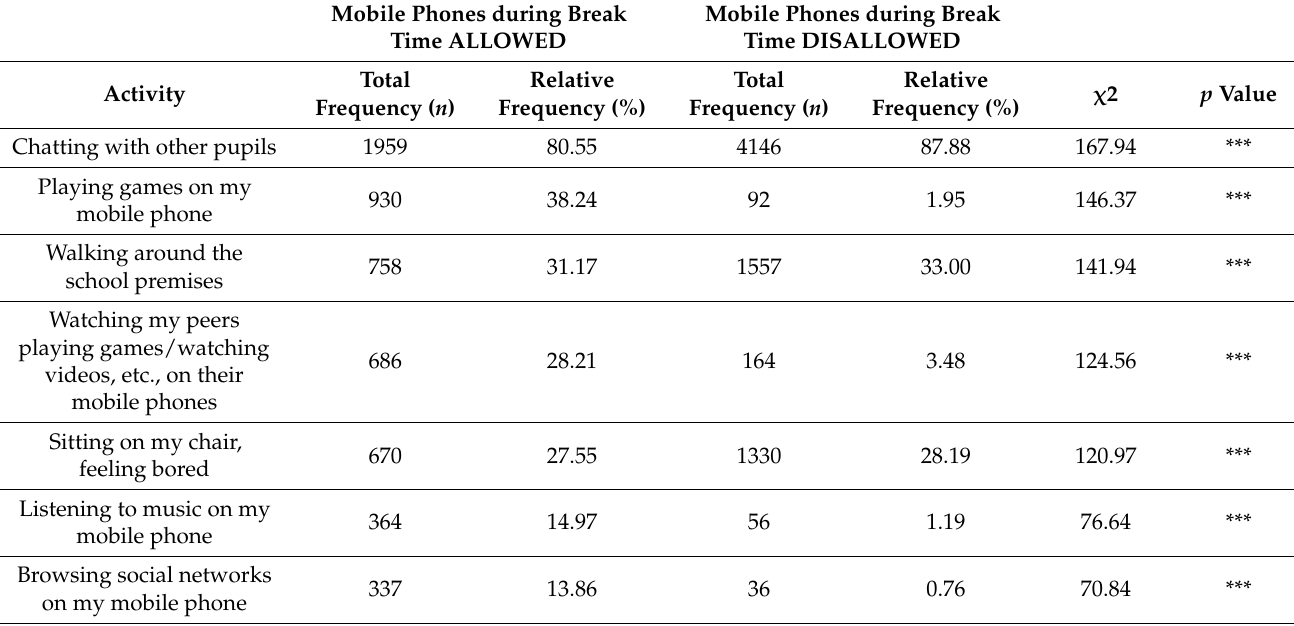
Table 5. What do primary tier (7–11-year-old) children do during break